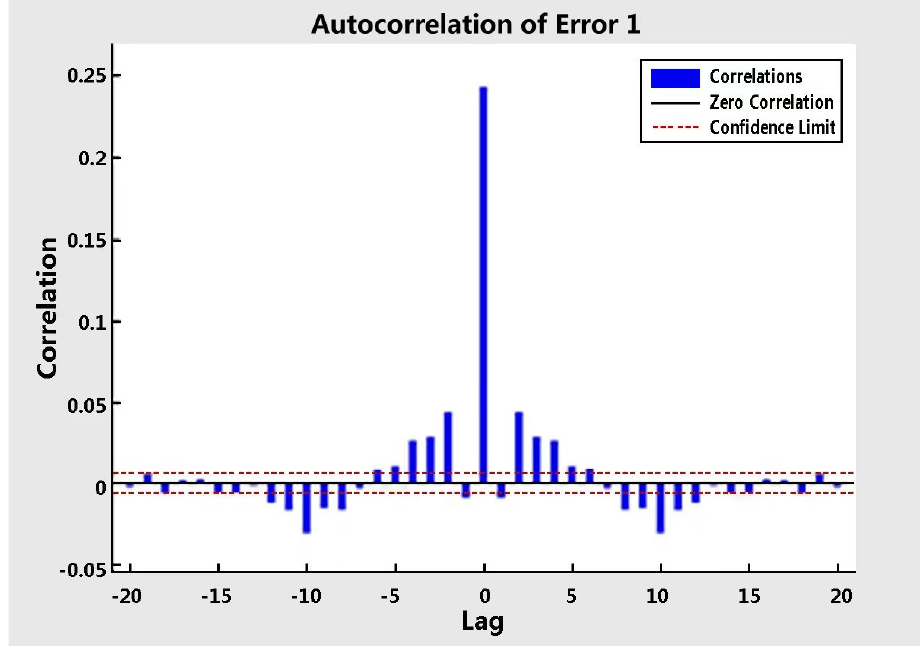
Figure 5. Output heart rate of time series response .